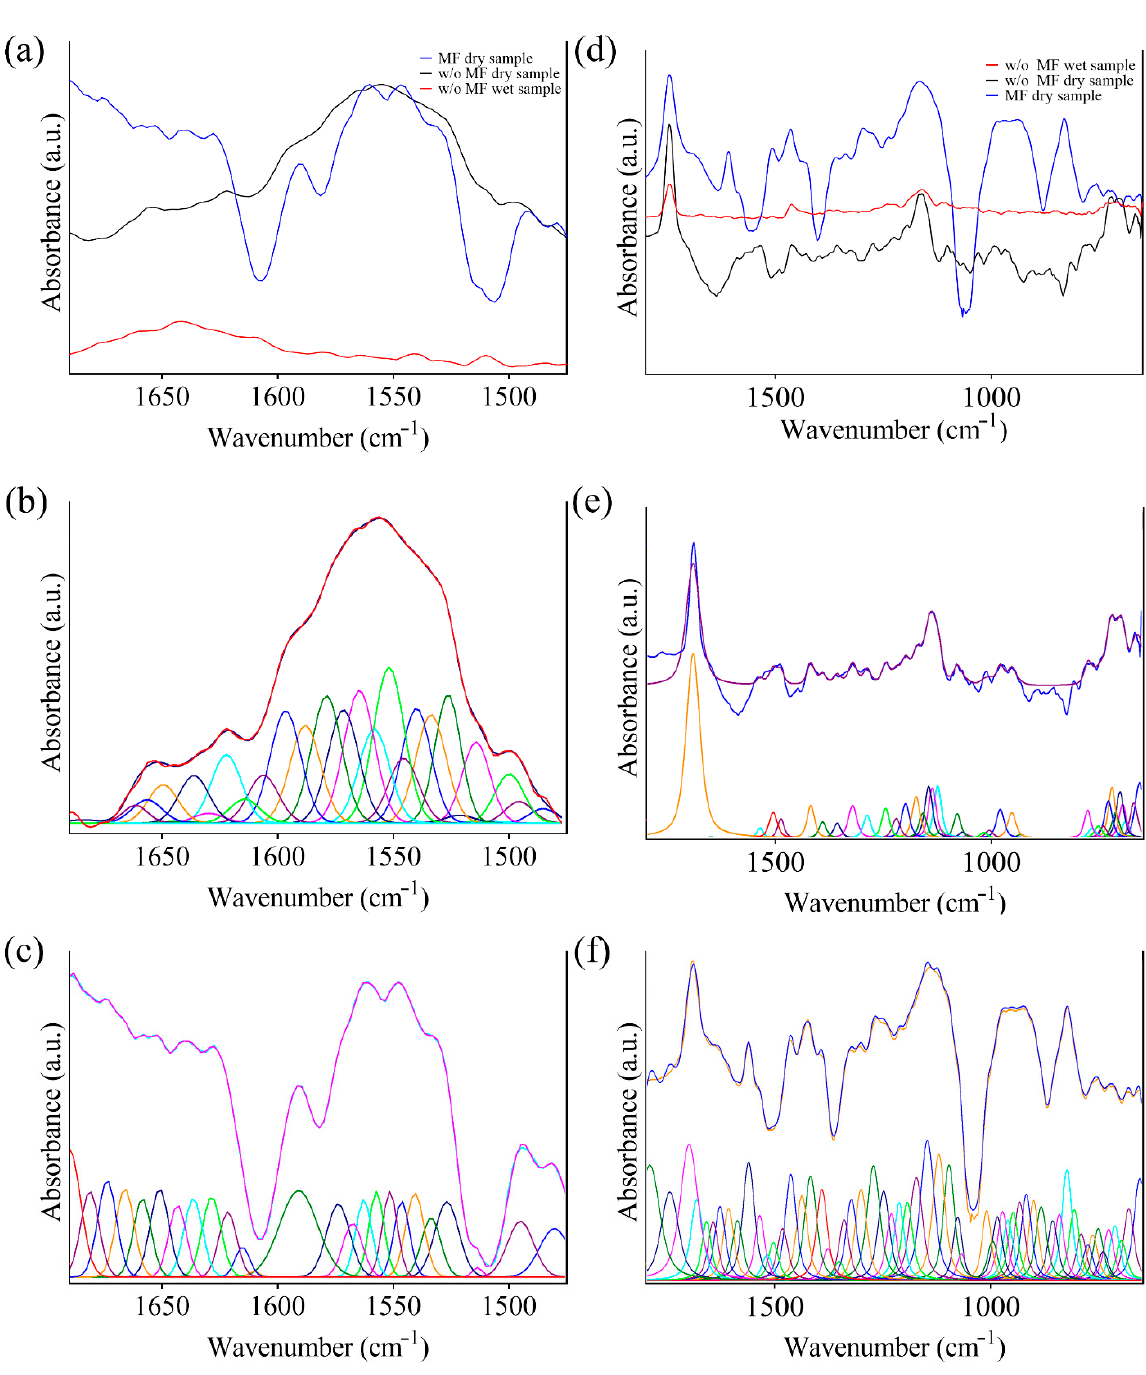
Figure 5. FT-IR spectra of ( a ) ketoprofen dried sample before and after MF treatment and of wet sample non exposed to magnetic field. Curve-fitting of ( b ) the ketoprofen control dried spectrum and ( c ) dried spectrum after MF treatment. ( d ) KiOil dried sample before and after MF treatment and of wet sample non exposed to magnetic field. Curve-fitting of ( e ) the KiOil control dried spectrum and ( c ) dried spectrum after MF treatment ( f